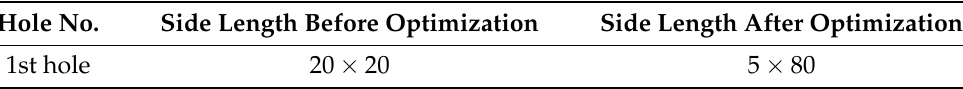
Figure 7. Comparison between surrogate model prediction and FEM result for the one-hole case: ( a ): temperature field with an optimized mask using a CNN surrogate model; ( b ): temperature field with an optimized cover using the FEM method; ( c ): quantitative comparison of the two results. Table 2. The shape optimization of the 1-hole